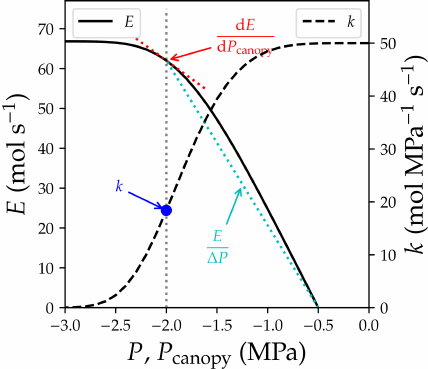
Figure 2. Difference between quantities used in plant hydraulics. The simulation is done for a plant with soil water potential of − 0 . 5MPa, no gravity term, and no drought legacy effect from pre- vious xylem embolism. See Table 1 for the list of